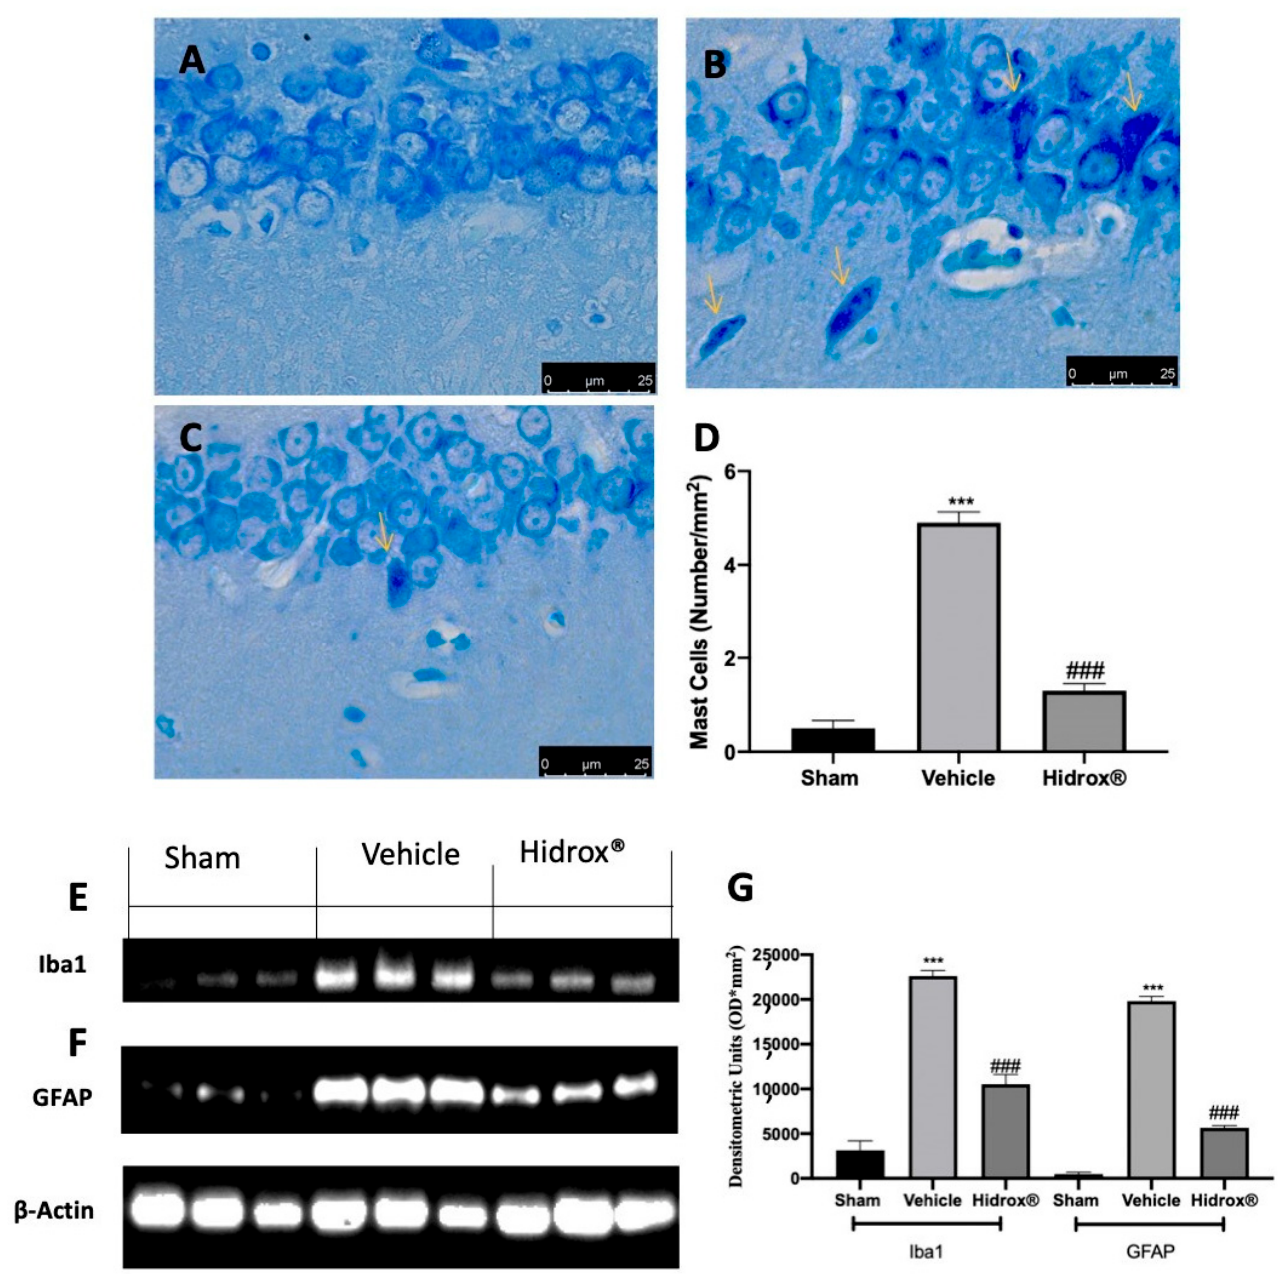
Figure 8. Hidrox ® administration reduced neuroinflammation endometriosis-induced: toluidine blue staining of hippocam- pal tissue: sham ( A ), vehicle ( B ), Hidrox ® ( C ), mast cell number ( D ), Western blot analysis of Iba from hippocampal tissue ( E ), GFAP from hippocampal tissue ( F ), densitometric analysis ( G ). For the analyses, n = 5 animals from each group were employed. A p-value of less than 0.05 was considered significant. *** p < 0.001 vs. sham, ### p < 0.001 vs.